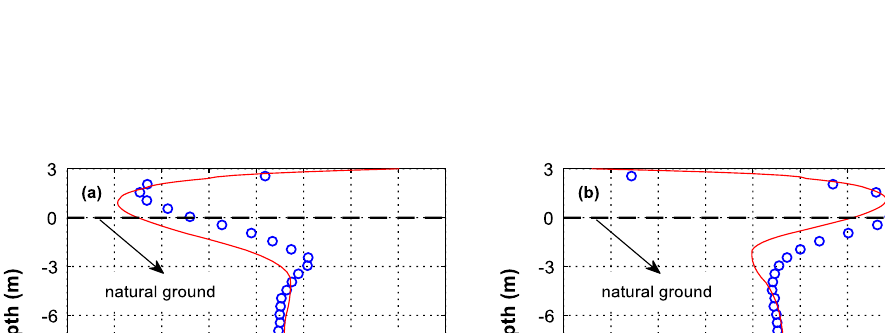
Figure 2. Soil temperature predicted by HFM. Location: at the natural borehole that is 20 m away from the side-slope toe ( a ) temperature serial at 0.5 m depth, with R 2 = 0.975, Mean = 0.134 °C and Std = 0.702 °C, ( b ) temperature serial at 0.5 m depth, ( c ) on April 20, 2002, and ( d ) on October 19, 2002.